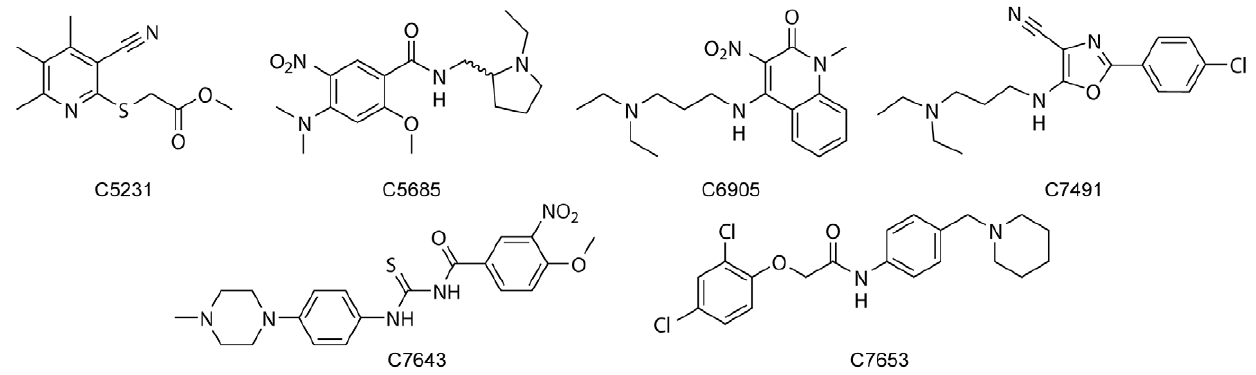
Figure 3. The chemical structures of the AChE inhibitors. The compounds C5231–C7653 were identified as hits in the HTS and their bioactive conformations were determined in complex with m AChE by X-ray